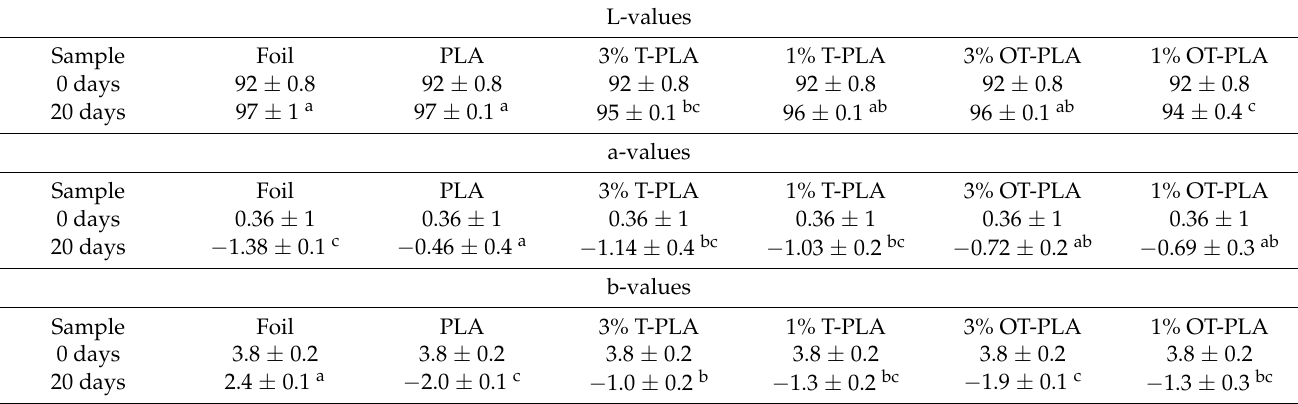
Figure 2. The light spectrum from the fluorescent bulbs was measured at 2393 lux by using a Upertek MK350S. Color changes Color changes of the green tea infusion between six different packaging conditions were measured on Days 0 and 20 (Table 3). Table 3. Color changes (mean ± standard deviation) in L*value (L*: 0 = black, 100 = white), a- and b-values of ready-to-drink (RTD) green tea in the glass bottles covered by foil, PLA, 3% T-PLA, 1% T-PLA, 3% OT-PLA and 1% OT-PLA nanocomposite films during storage of 0 and 20 days at 4 ◦ C under fluorescent light. Different letters next to the data indicate statistical differences between L, a- and b-values of the color at p <